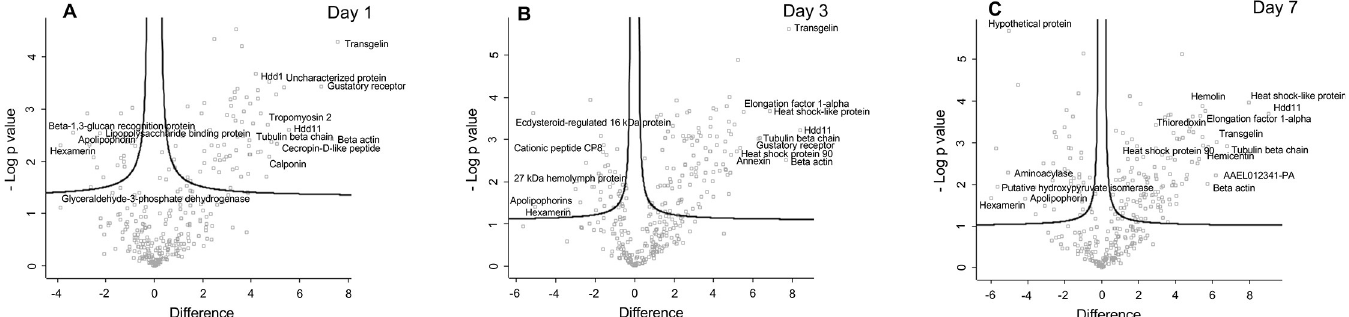
Fig 5. Proteomic responses of G . mellonella larvae following infection by M . mycetomatis mycelium after 24 hour (A), 72 hour (B) and 7 days (C) post infection. Volcano plots represent protein intensity difference ( − log2 mean intensity difference) and significance in differences ( − log P-value) based on a two-sided t-test. Proteins above the line are considered statistically significant (p value < 0.05) and those to the right and left of the vertical lines indicate relative fold changes > 1.5. Annotations are given for the most differentially abundant proteins identified in hemolymph from larvae infected with M . mycetomatis mycelium after 24 hour, 72 hour and 7 days. These plots are based upon post imputed